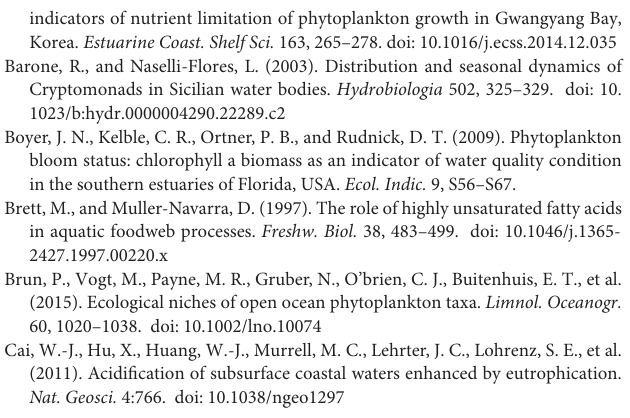
Supplementary Figure 1 | Long-term variation in cryptophytes and diatoms in response to variation in water quality parameters. Variations in cryptophytes and diatoms with the water quality index (A,B) , variations in cryptophytes and diatoms with the proportion of NH 4 + in the surface and bottom waters (C,D) , and variations in cryptophytes and diatoms with the photic depth in the surface and bottom waters (E,F) . Supplementary Table 1 | Long-term variation in dominant species for the last 11 years in Yeongil Bay. Parenthesis illustrates dominance